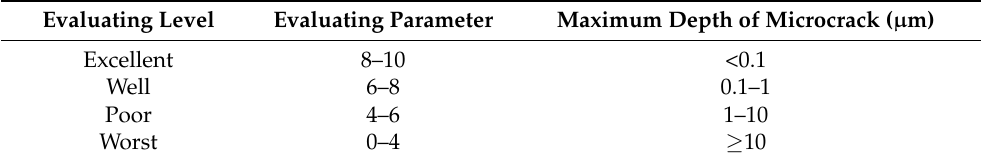
Table 6. Evaluation basis for surface microcrack depth.